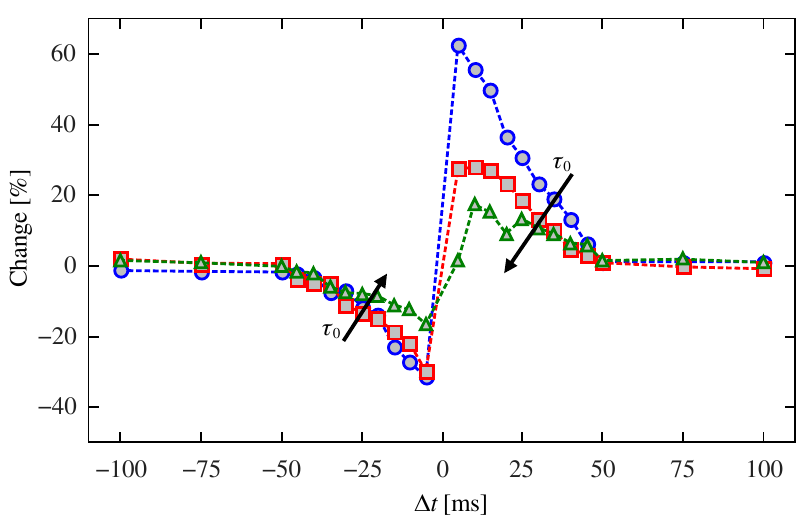
Figure 9. Percentage of change of the resistance vs. ∆ t for characteristics times τ 0 = 5 (blue), 10 (red), and 20 s (green). The larger the τ 0 , the weaker the learning